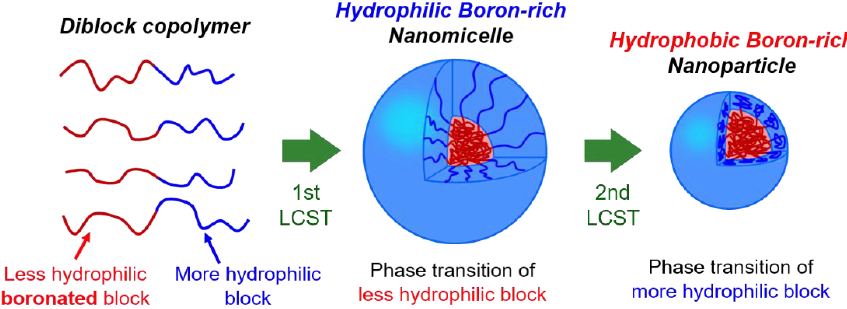
Figure 1. Schematic illustration of two-step phase transition of thermoresponsive boron-containing diblock copolymers.